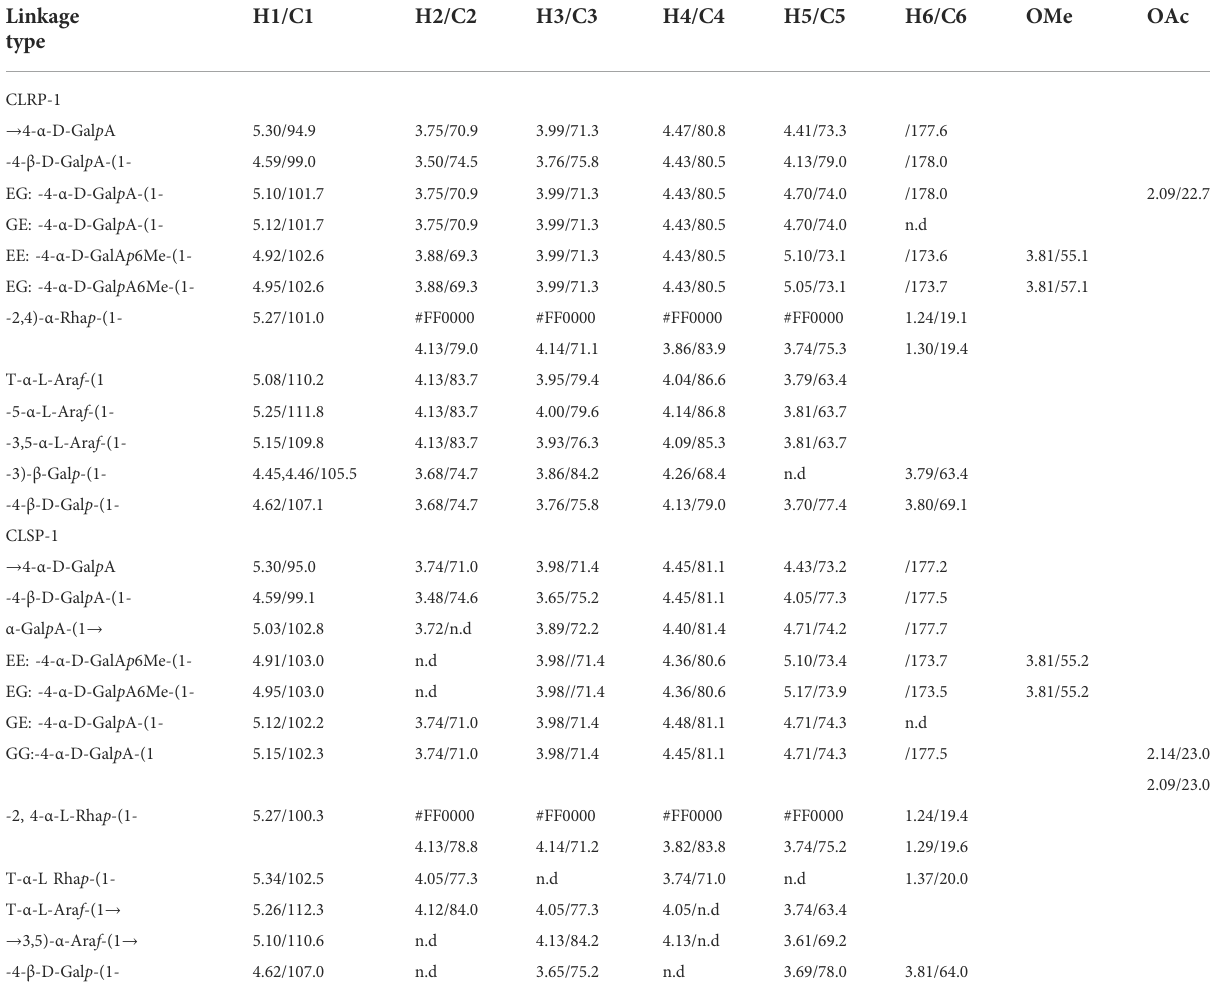
TABLE 3 1 H and 13 C chemical shifts (ppm) of polysaccharide fraction of CLRP-1 and CLSP-1. Linkage